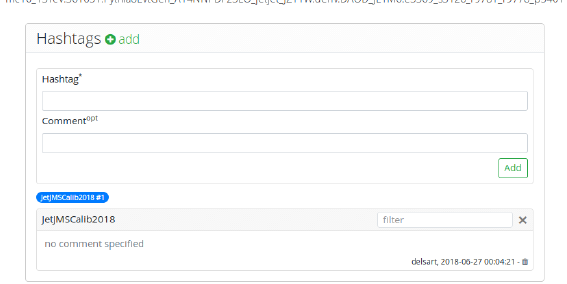
Fig. 9. Embeding AWF “table” graphical control in a Web page.